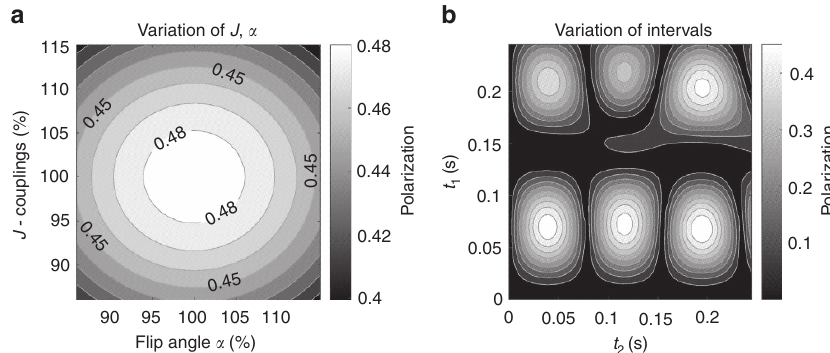
Figure 1 | Simulated stability and intervals of l-PHINEPT for SAMBADENA. The resulting polarization of the SOTsequence l-PH-INEPT þ (longitudinal- para hydrogen-insensitive nuclei enhancement by polarization transfer) was simulated as function of erroneous J -couplings and flip angles ( a ) and as function of the evolution intervals ( b ). J represents the J -couplings of the simplified 3-spin-½ system of the tracer and a represents the flip angle of the pulses of the sequence; both values were varied by ± 15%. The values of t 1 and t 2 denote the free evolution intervals between the effective pulses of the SOT sequence (see Fig.